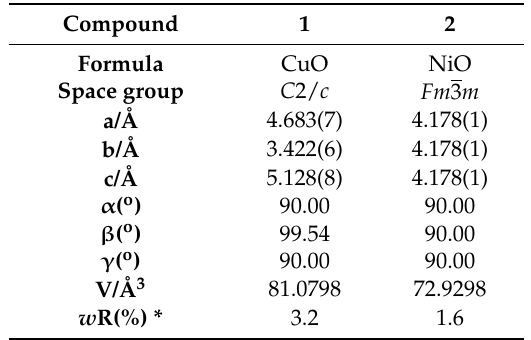
Table 2. Crystallographic data for the compound Cu–Ni_0.20_500, obtained by refinement by the Pawley method. Compound 1 2 Formula CuO NiO Space group C 2/ c Fm 3 m a/Å